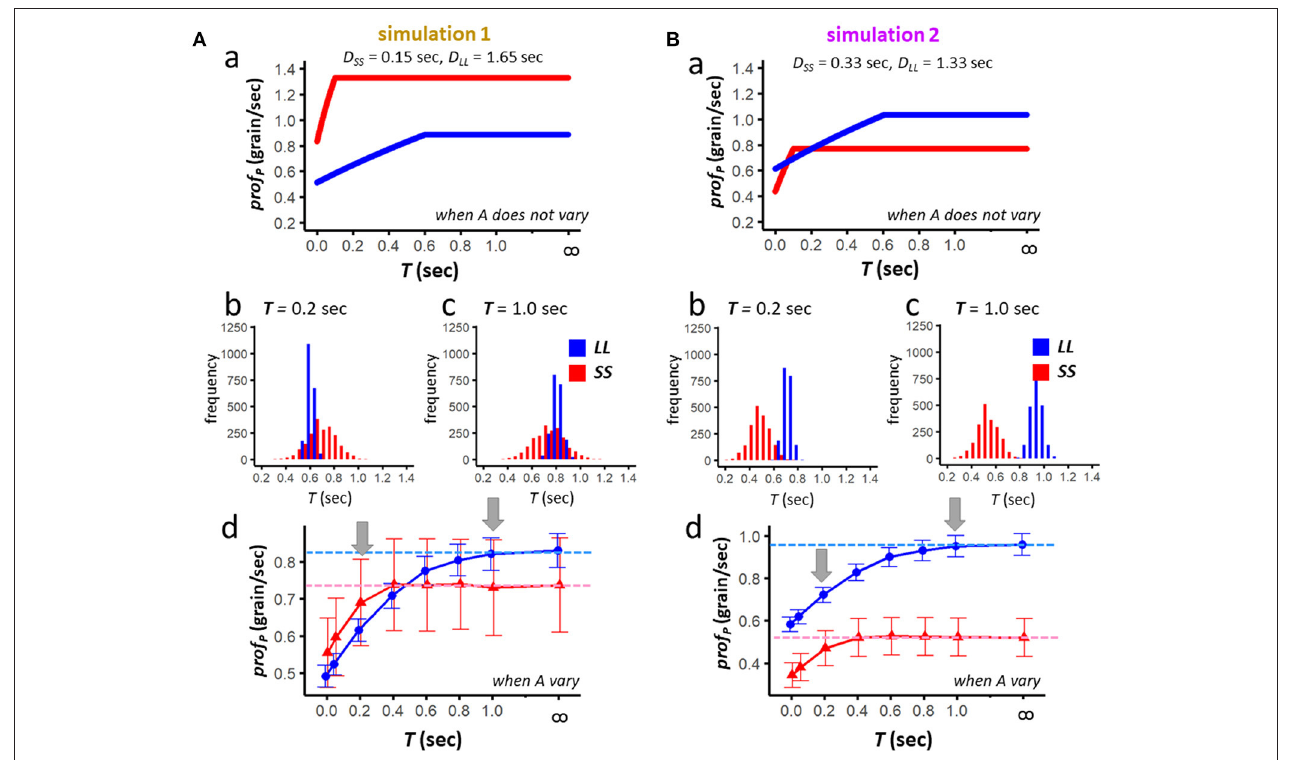
FIGURE 5 | Results of the numerical simulation 1 (A) and simulation 2 (B) . For each set of simulation parameters, averaged profitability of LL (blue) and SS (red) is examined in two conditions; namely, when the food amount does not vary ( A a, B a), and when it varies from trial to trial ( A b–d, B b–d). Results of 2,000 simulated sessions (each representing average of 72 trials) are shown for T (0.00, 0.05, 0.20, 0.40, 0.60, 0.80, 0.10, and 999 or ∞ ); mean and standard deviation are shown each. Dashed horizontal lines in ( A d, B d) denote the profitability when scrounging does not